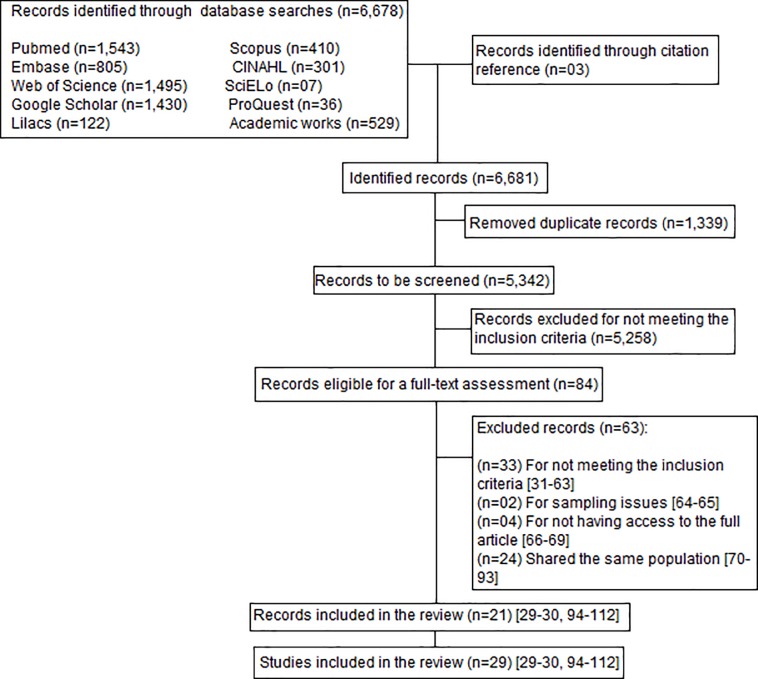
Flowchart of the study selection process.